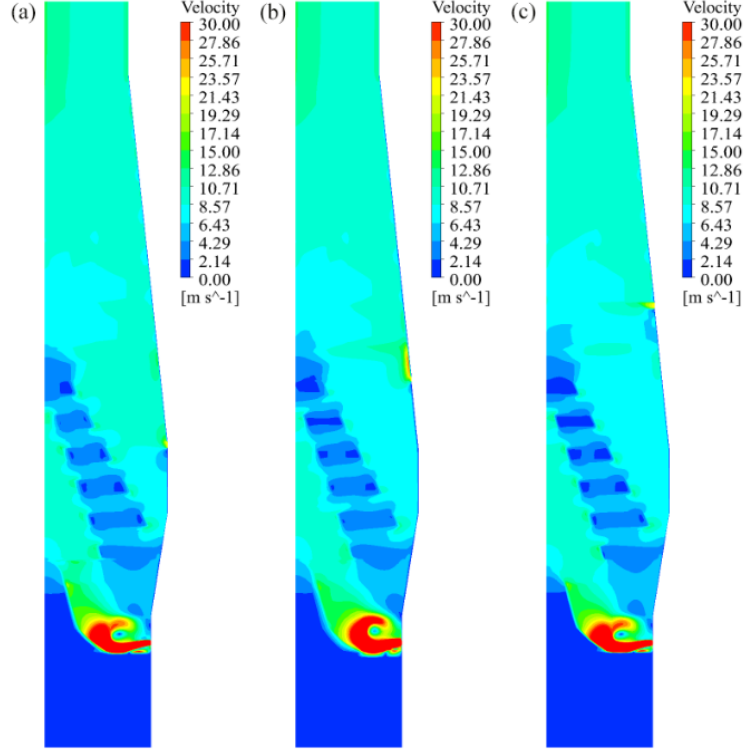
Figure 7. Pressure contour of three stack tuyere heights (R = 60%, blast velocity = 23 m/s): ( a ) H = 0.0 m, ( b ) H = 1.8 m, ( c ) H = 3.6 m.